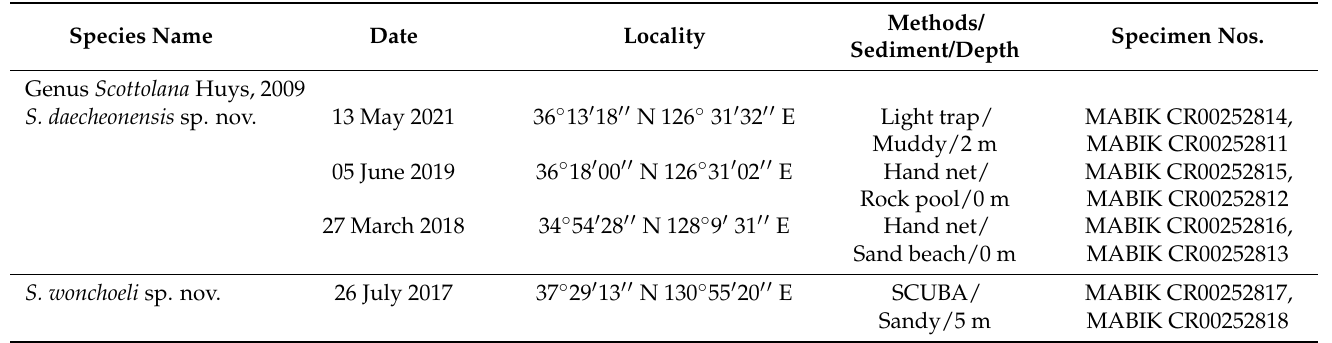
Table 1. Information regarding collection and specimens in this